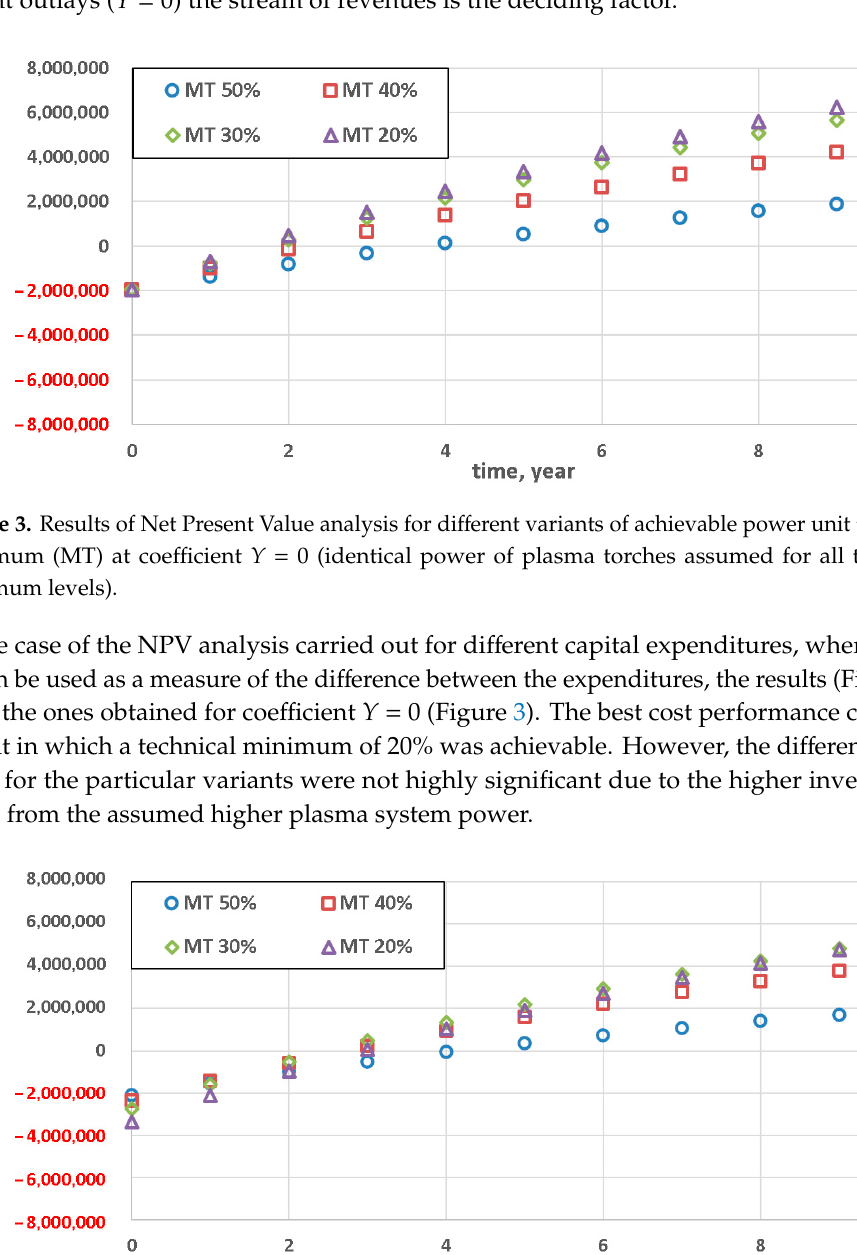
Figure 4. Results of NPV analysis for di ff erent variants of achievable power unit technical minimum (MT) at coe ffi cient Y = 0.5 (identical power of plasma torches assumed for all technical minimum